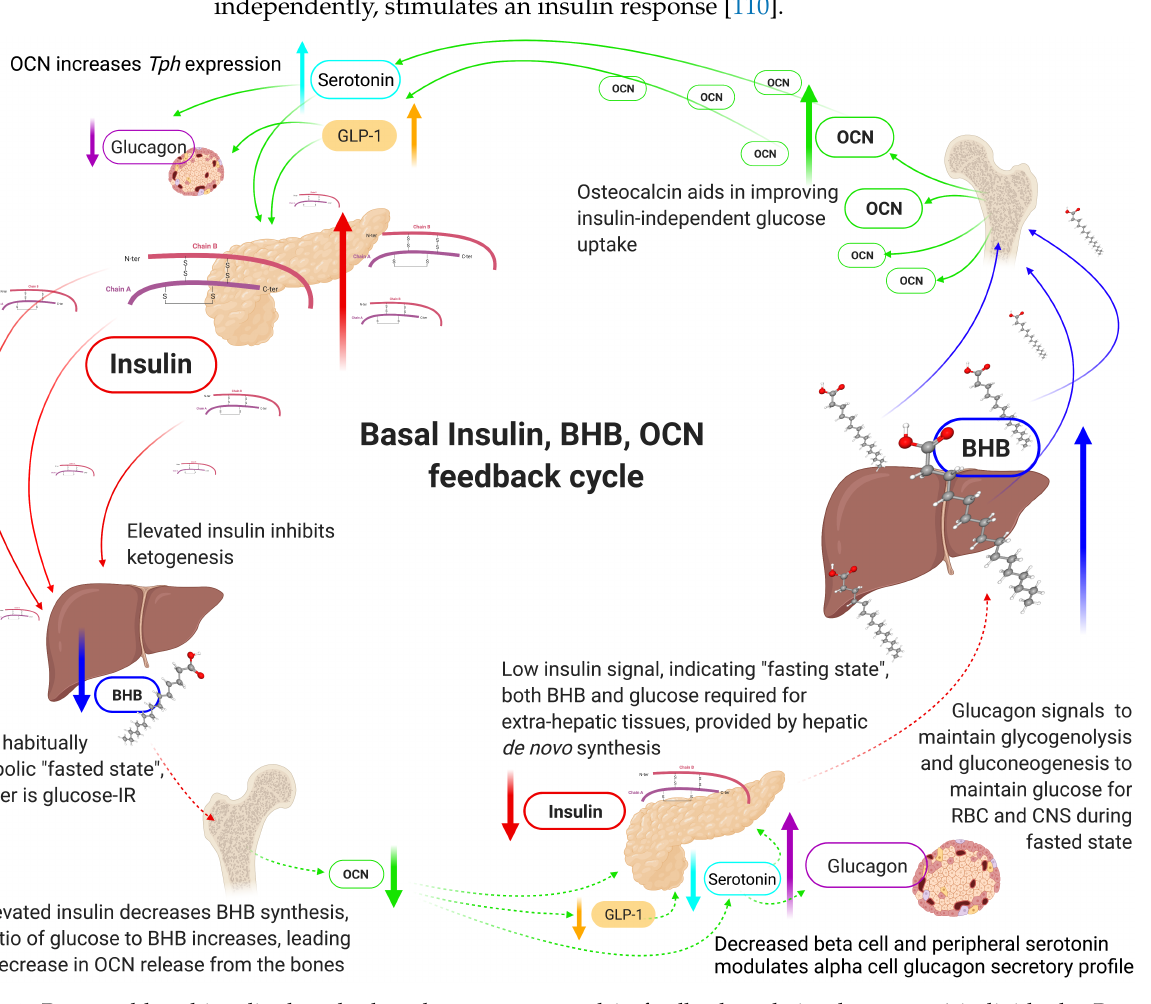
Figure 4. Proposed basal insulin, beta-hydroxybutyrate, osteocalcin feedback cycle in phenotype-1 individuals. Beta- hydroxybutyrate (BHB), central nervous system (CNS), glucagon-like peptide-1 (GLP-1), insulin resistance (IR), glucose- insulin resistance (IR-G), osteocalcin (OCN), red blood cells (RBC), tryptophan hydroxylase ( Tph